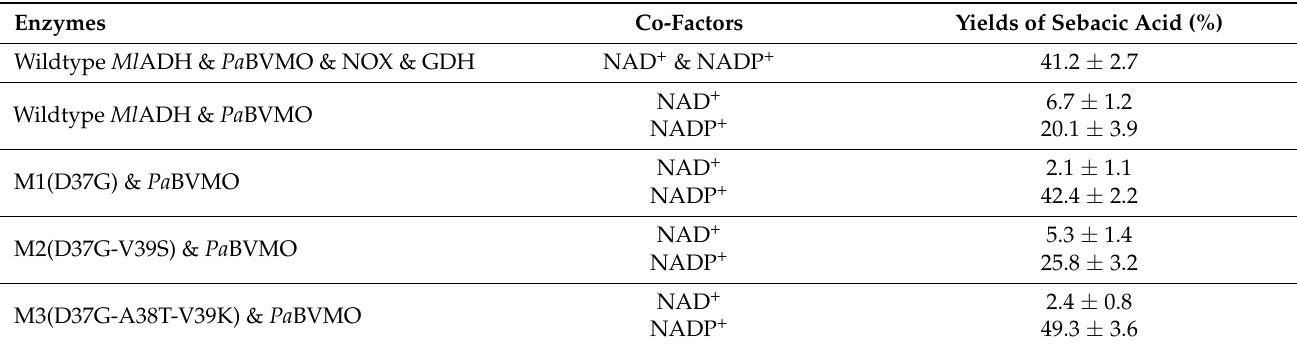
Table 2. Yields of sebacic acid by multistep catalytic reactions through different combinations of Ml ADH or its variants and Pa